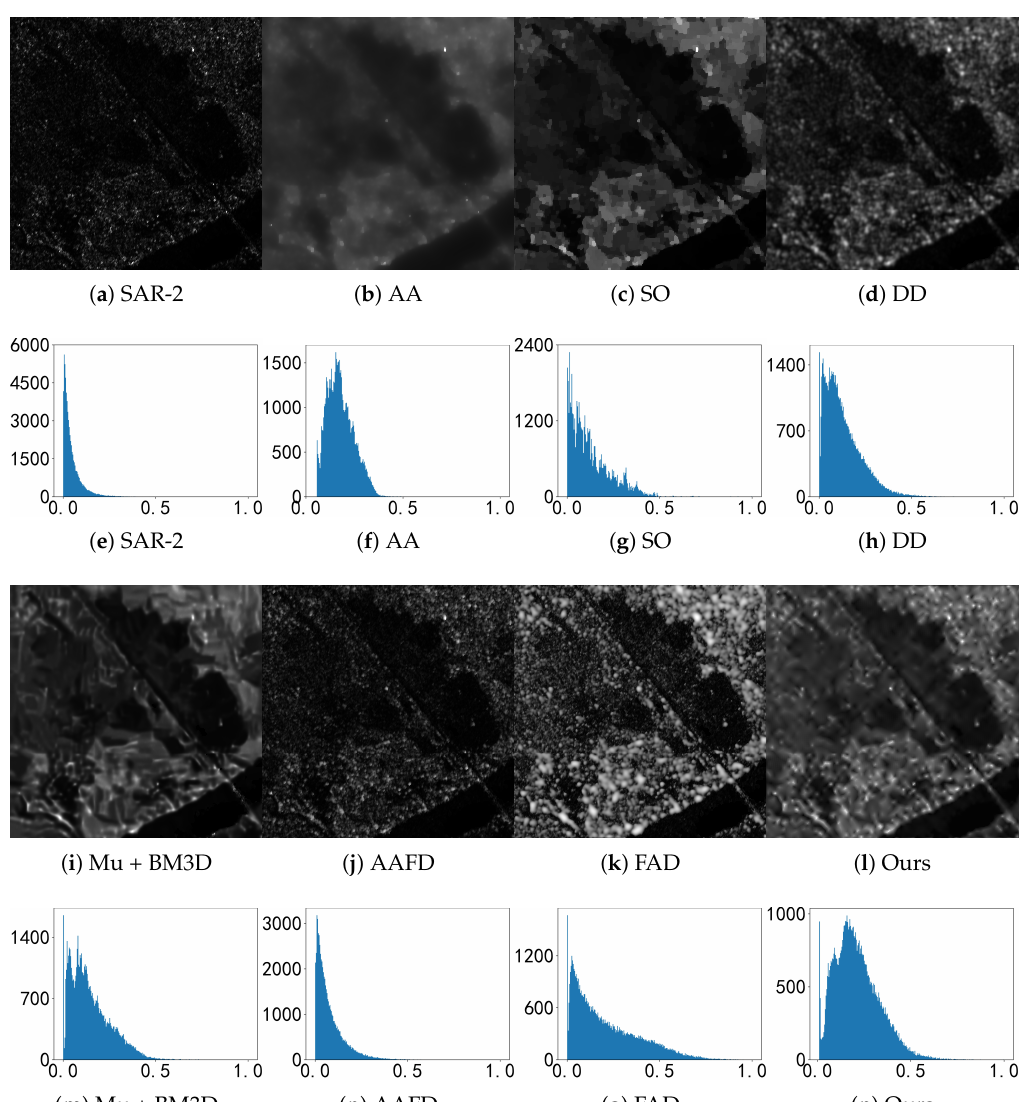
Figure 11. Denoised results and the corresponding histograms.